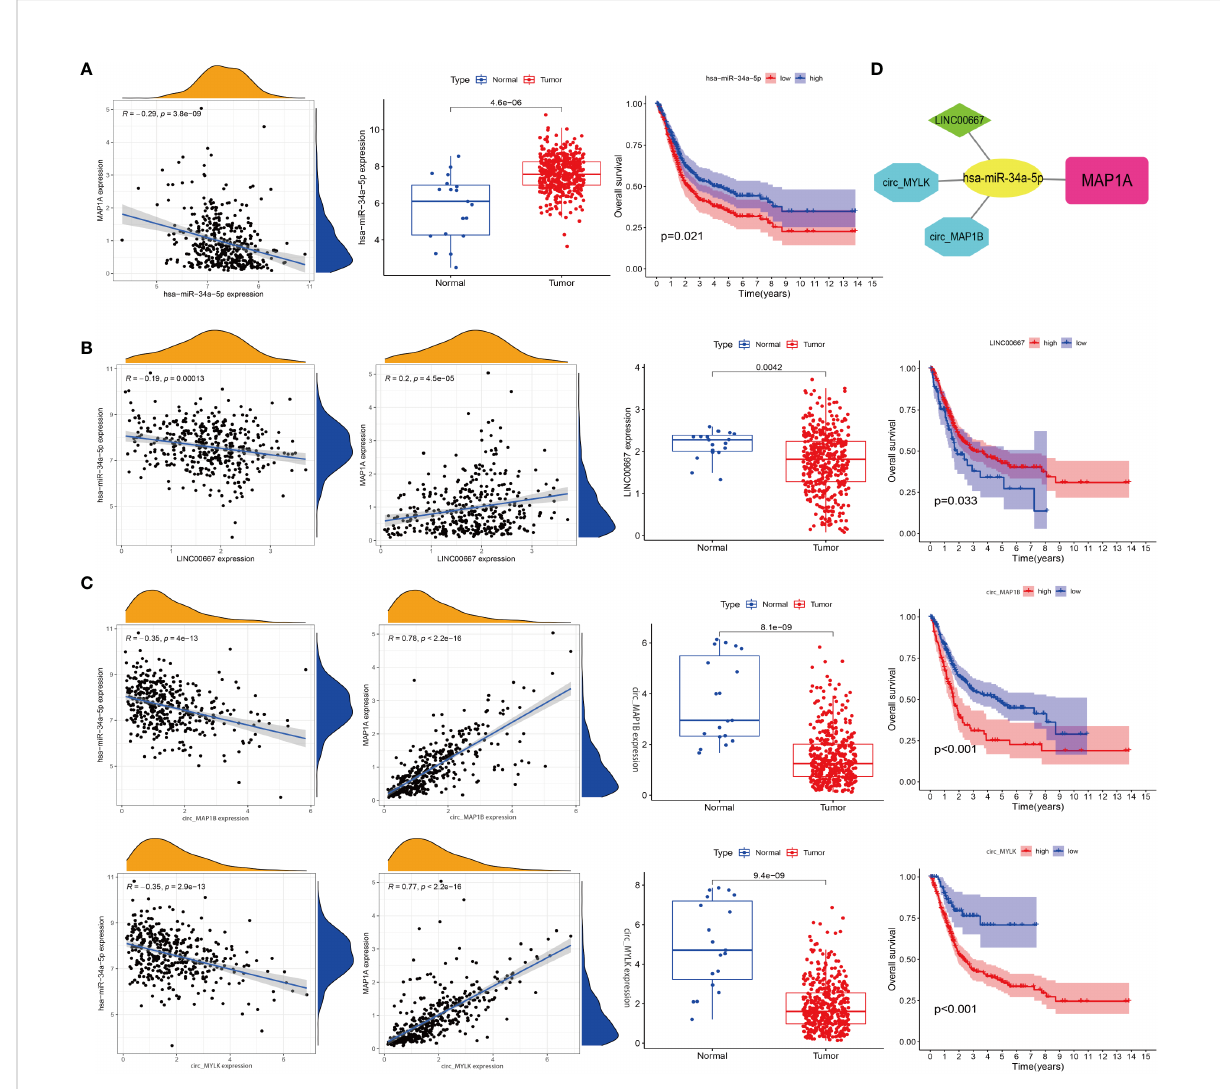
FIGURE 8 Construction of a ceRNA network. (A) Correlation analysis of miR-34a-5p with MAP1A, miR-34a-5p expression in bladder cancer tissues and paracancer tissues, and correlation analysis of miR-34a-5p expression with bladder cancer patients ’ survival. (B) Analysis of the relationships between LINC0667, MAP1A, and miR-34a-5p expression, analysis of LINC0667 expression in bladder cancer and paracancer tissues, and correlation analysis of LINC0667 expression with bladder cancer patient survival. (C) Correlation analysis between circ_MAP1B and circ_MYLK with MAP1A and miR-34a-5p expression, analysis of circ_MAP1B and circ_MYLK expression in bladder cancer tissues and paracancer tissues, correlation analysis of circ_MAP1B and circ_MYLK expression with survival of bladder cancer patients. (D) Visualization map of ceRNA interaction network by cytoscape